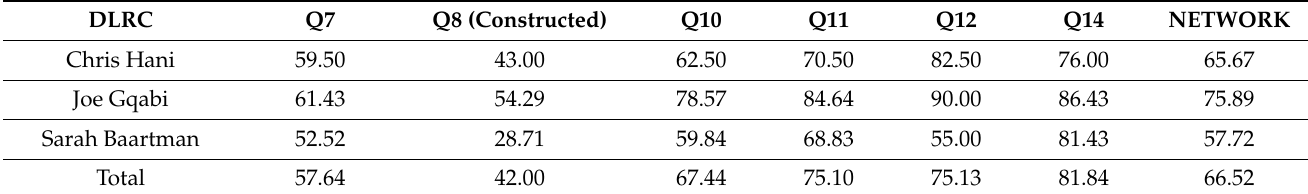
Table 5. Network interactions (average standardized assessment score in %).